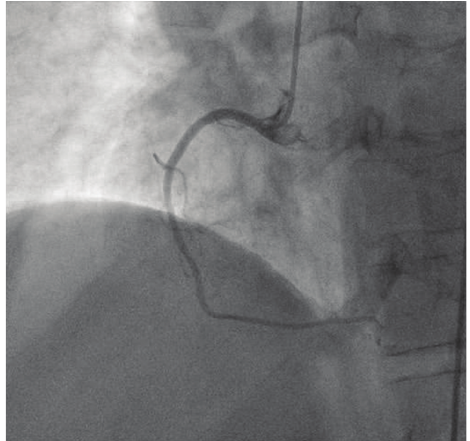
Figure 2: Coronary angiography of the right coronary tree with no angiographic evidence of obstructive disease.